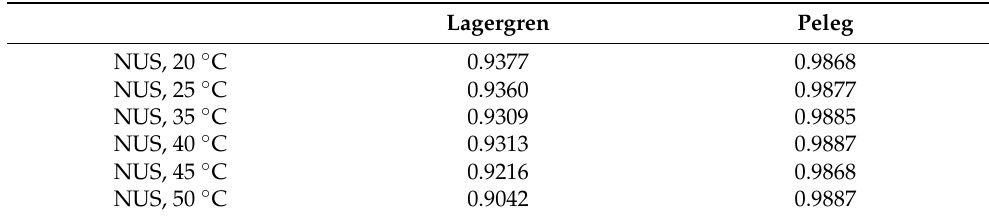
Table 1. Thermal extraction R 2 values (NUS) by applying the two proposed kinetic models on the experiments’ TPI vs. time plots.